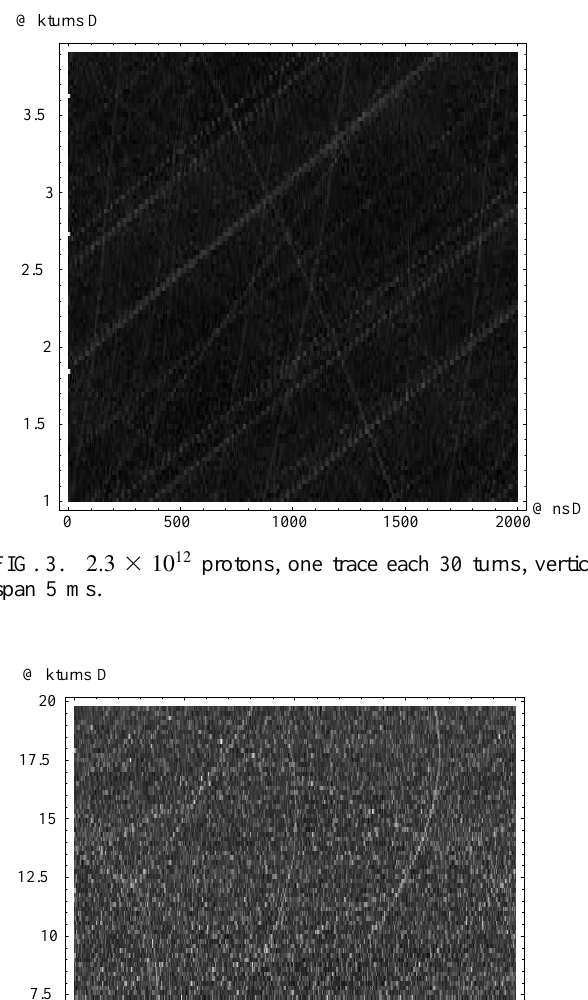
FIG. 5. 1.7 3 10 12 protons, Schottky scan about h (cid:1) 4 .